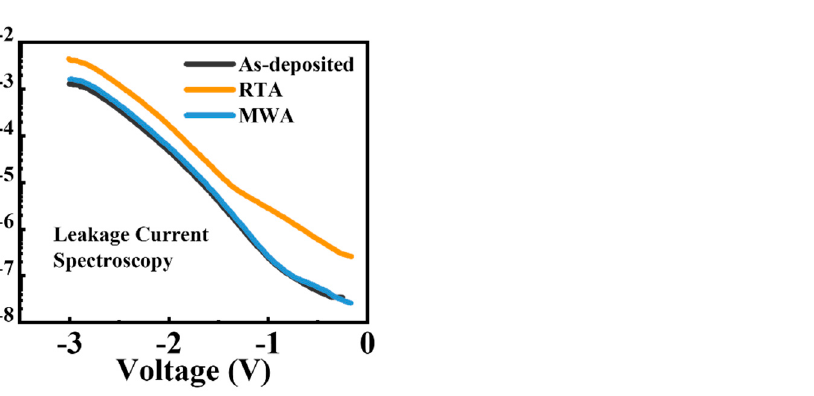
Figure 5. False-color EDX maps and high-angle annular dark-field (HAADF) images represent the average composition of the HZO films with ( a ) MWA and ( b ) RTA treatment.